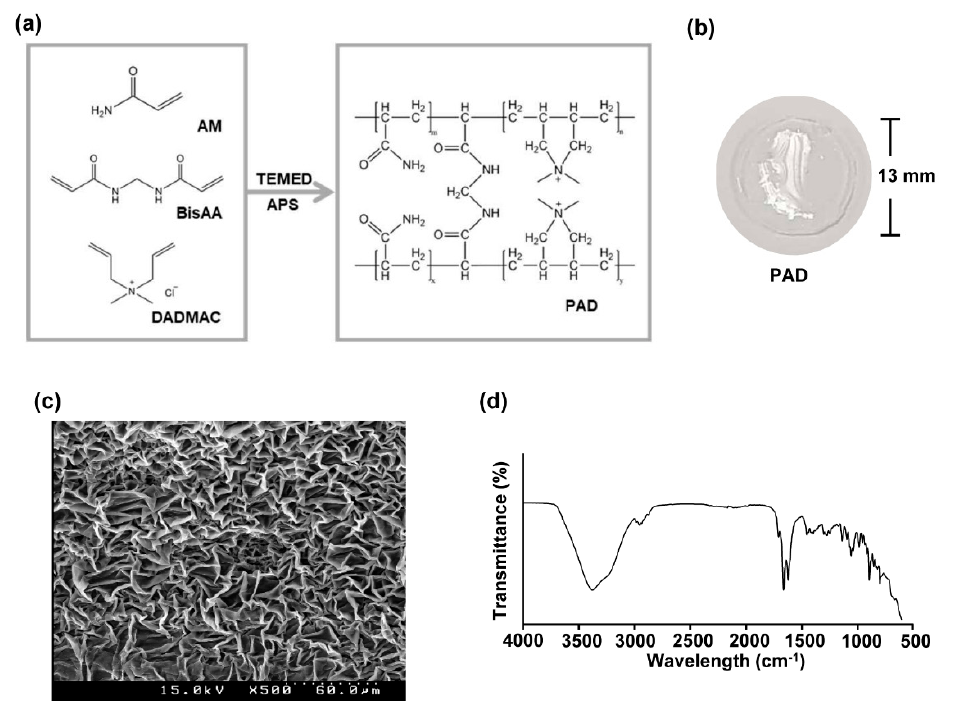
Figure 1. Structure and characterization of the PAD hydrogel: ( a ) synthetic scheme of the PAD hydrogel, ( b ) photograph of the PAD hydrogel, and ( c ) the SEM image of the lyophilized PAD hydrogel, and ( d ) the FTIR spectrum of the PAD hydrogel.